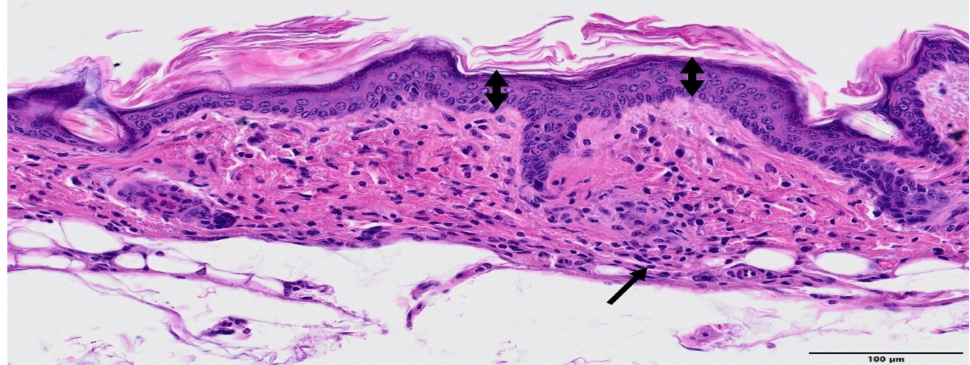
Figure 10. MBRT irradiation. HE staining. Higher magnification. Bar = 100 µ m. Higher magnification that shows the epidermal focal increase from 1–2 layers (left and right edges) to 4–5 multiple layers (minimal epidermal hyperplasia, double-headed arrow). The subepidermal presence of small clusters of inflammatory cells